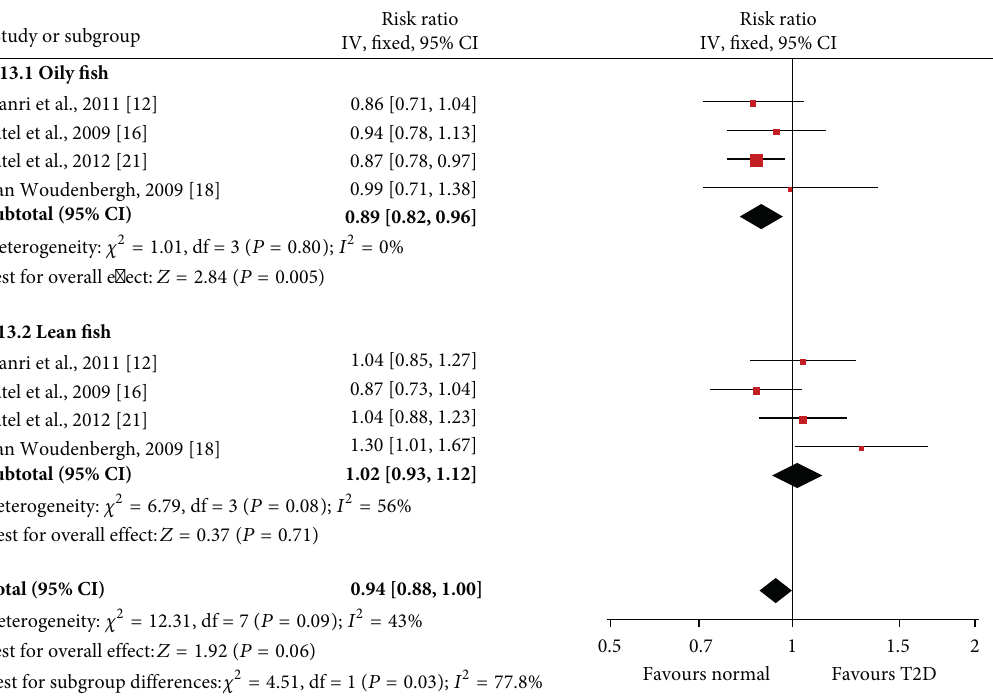
Favours normal Favours